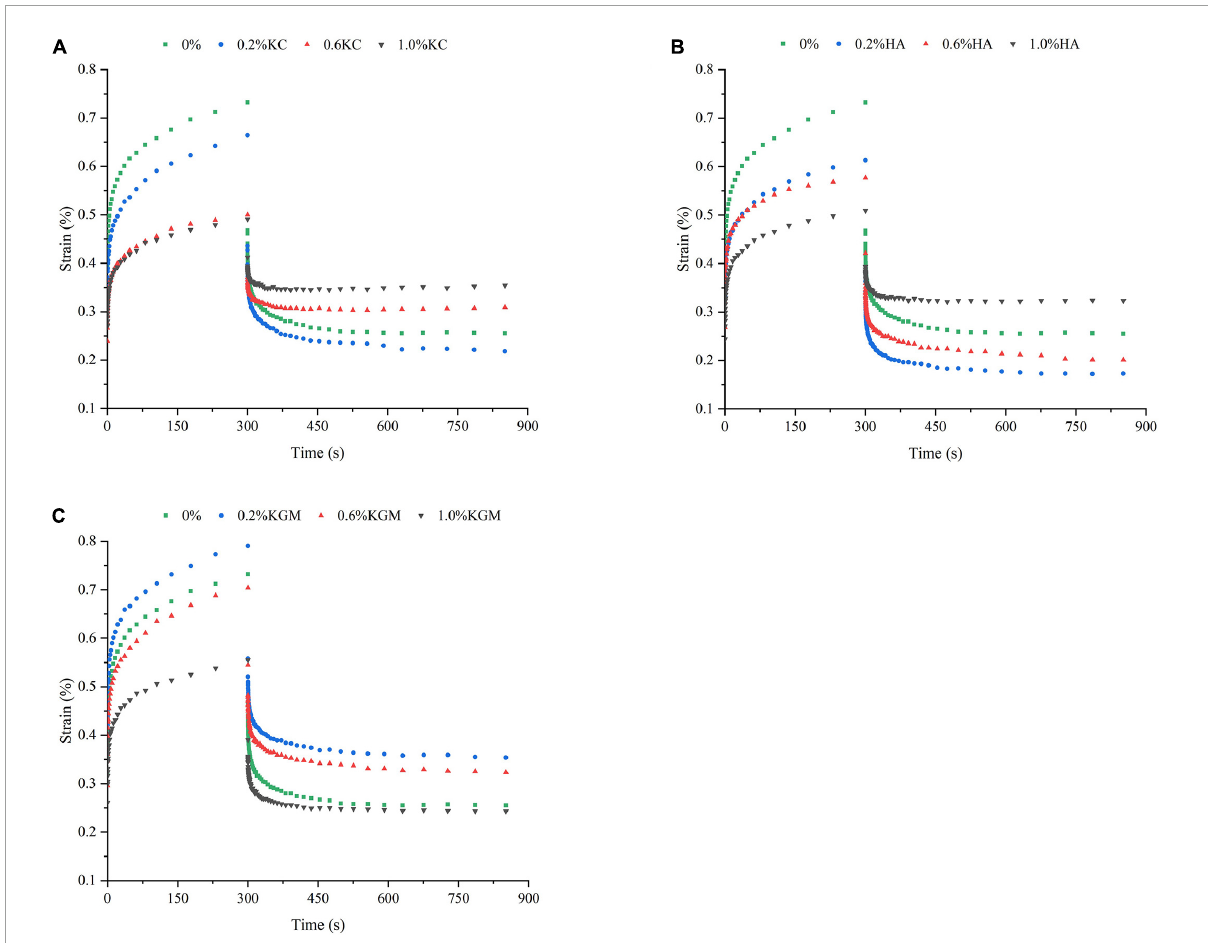
FIGURE4 Creep-recovery behavior of emulsion gels containing different polysaccharides: (A) κ C, (B) HA, and (C) KGM. κ C, κ -carrageenan; HA, high-acyl gellan; KGM, konjac